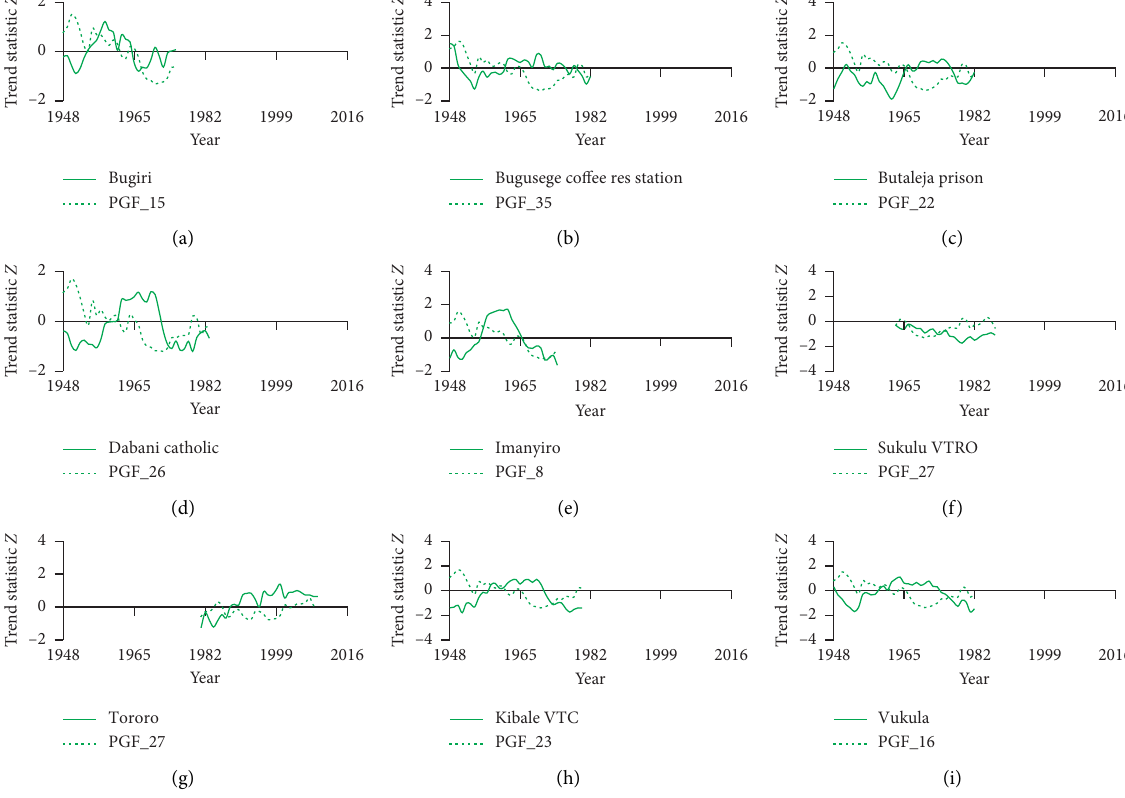
Figure 13: Variability of JJAS PGF and observed rainfall at stations (a) 1, (b) 2, (c) 3, (d) 4, (e) 5, (f) 6, (g) 7, (h) 8, and (i)